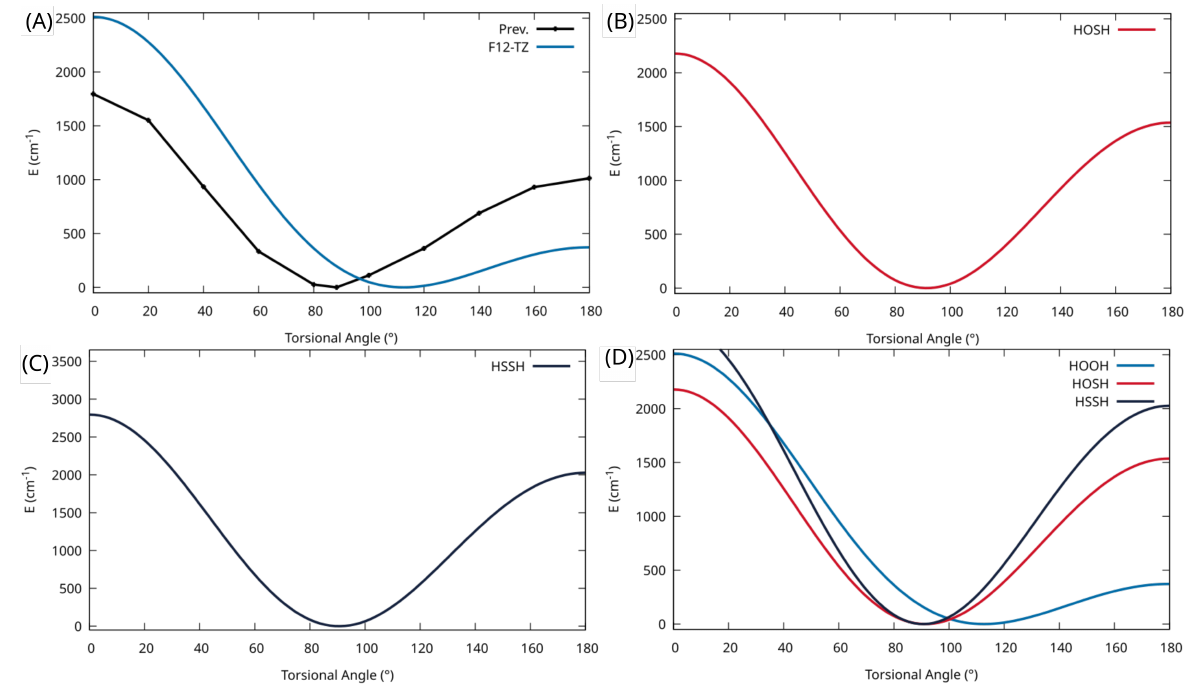
Figure 2. Potential energy scan of the torsional motion. ( A ) HOOH calculated at the F12-TZ level of theory (blue) and a previous theoretical study using HF/STO (black), ( B ) HOSH calculated at the F12-TZ level of theory, ( C ) HSSH at the F12-TZ level of theory, ( D ) comparison of HOOH, HOSH, and HSSH. Table 3. Vibrational frequencies (cm − 1 ) and IR intensities (km/mol) given in parentheses for two- quanta bands of HOOH compared to previous gas-phase experiment. Prev.